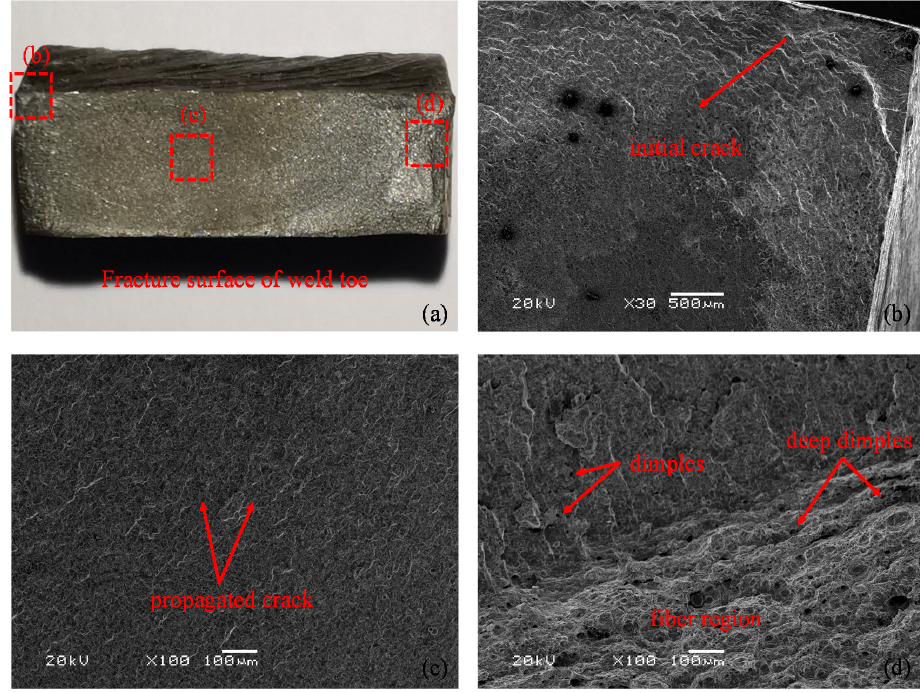
Table 5. The cumulative damage entropy (CDE) of three specimens and CDE when the stress am- plitude is 148.5 MPa. Figure 10. Fractographic analysis of Q460 welded joints: ( a ) fracture surface of weld toe; ( b ) initial crack; ( c ) propagated crack; ( d ) fiber region.